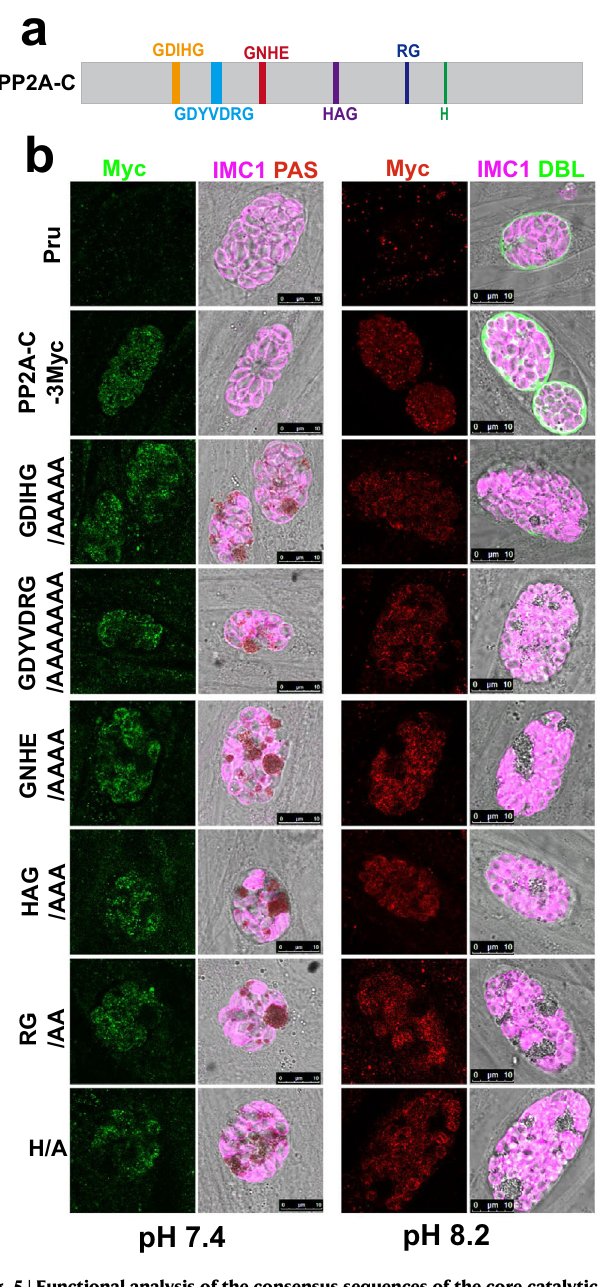
Fig. 5 | Functional analysis of the consensus sequences of the core catalytic motif of PP2A-C. a Schematic representation of the gene model for PP2A-C with thesixconsensussequencesofthecorecatalyticmotif. b PASstainingofPru Δ pp2a- c tachyzoitesexpressingthewild-typeormutantversionofPP2A-Cfusedwith3Myc tags under control of endogenous promoters, under normal culture (pH 7.4) or alkalinecultureconditions(pH8.2).The amylopectinwasstainedwithPASandthe tagged protein was detected using anti-Myc antibody (green or red), followed by immuno fl uorescence detection of the parasites using anti-IMC1 antibody (magenta). Scale bar, 10 µ